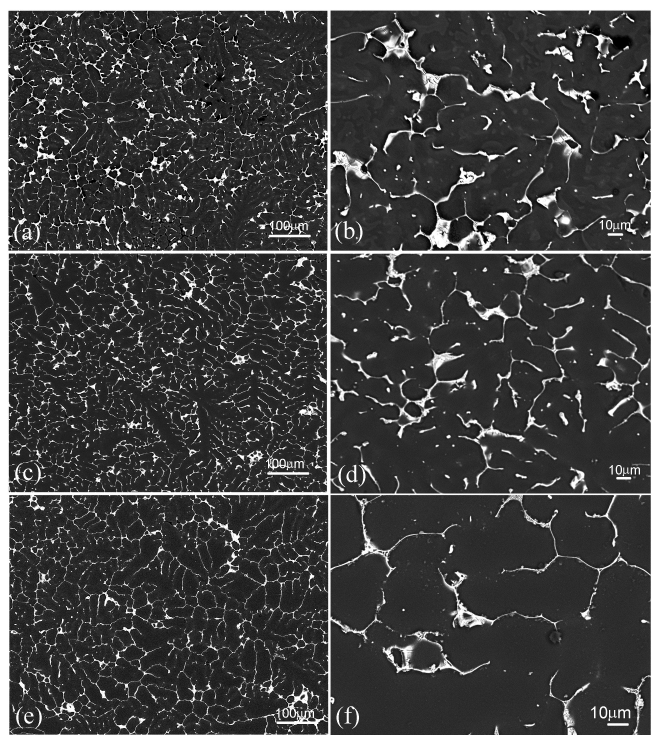
Figure 3. Solidification microstructure at the center of the casting, observed by SEM, for ( a , b ) Chill, ( c , d ) Conventional and ( e , f ) Water-cooled castings. ( b , d , f ) are higher magnification micrographs of ( a , c , e ), respectively.